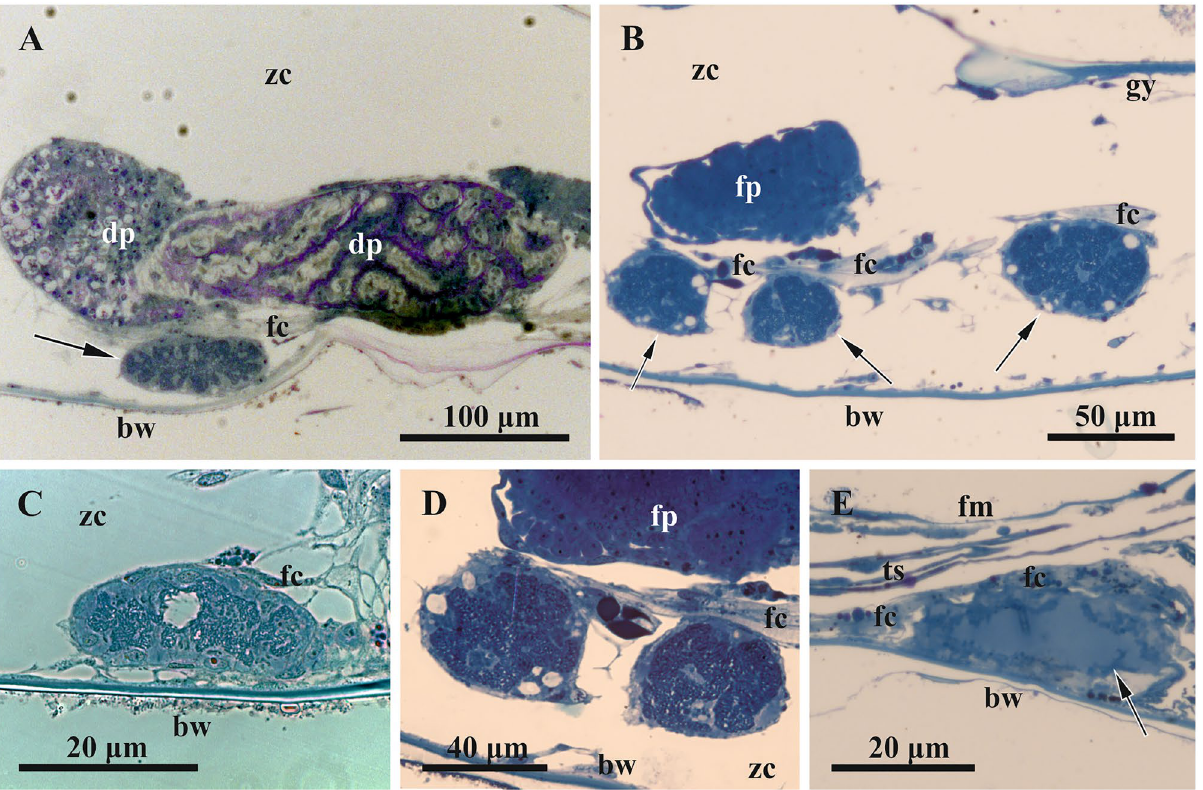
Figure 3. General view of funicular bodies inside the zooidal cavity in Dendrobeania fruticosa ( A – D , collected on 23 June 2018, E , collected on 31 September 2019) (longitudinal stained sections, light microscopy). ( A ) Mature non-modified FB (arrow) situated between the basal zooidal wall and the degenerating polypide; part of the funicular cord is sandwiched between the FB and the polypide. ( B ) Zooid showing two cross-sectioned parts of one lobed FB below growing polypide bud, and part of the second FB to the right (all FBs shown by arrows); a large funicular cord runs above both FBs. ( C ) Mature non-modified FB situated on basal wall of zooid and connected to thin processes of funicular cells. ( D ) Enlarged view of two parts of one FB shown in ( B ) (in C and D FBs show the initial stage of degradation, visible as large ‘vacuoles’ potentially reflecting either cell degradation or a fixation artifact). ( E ) Collapsing FT. bw basal wall, dp degenerating polypide, fc funicular cord, fm frontal membrane, fp forming polypide bud, gy gymnocyst, ts tentacle sheath, zc zooidal